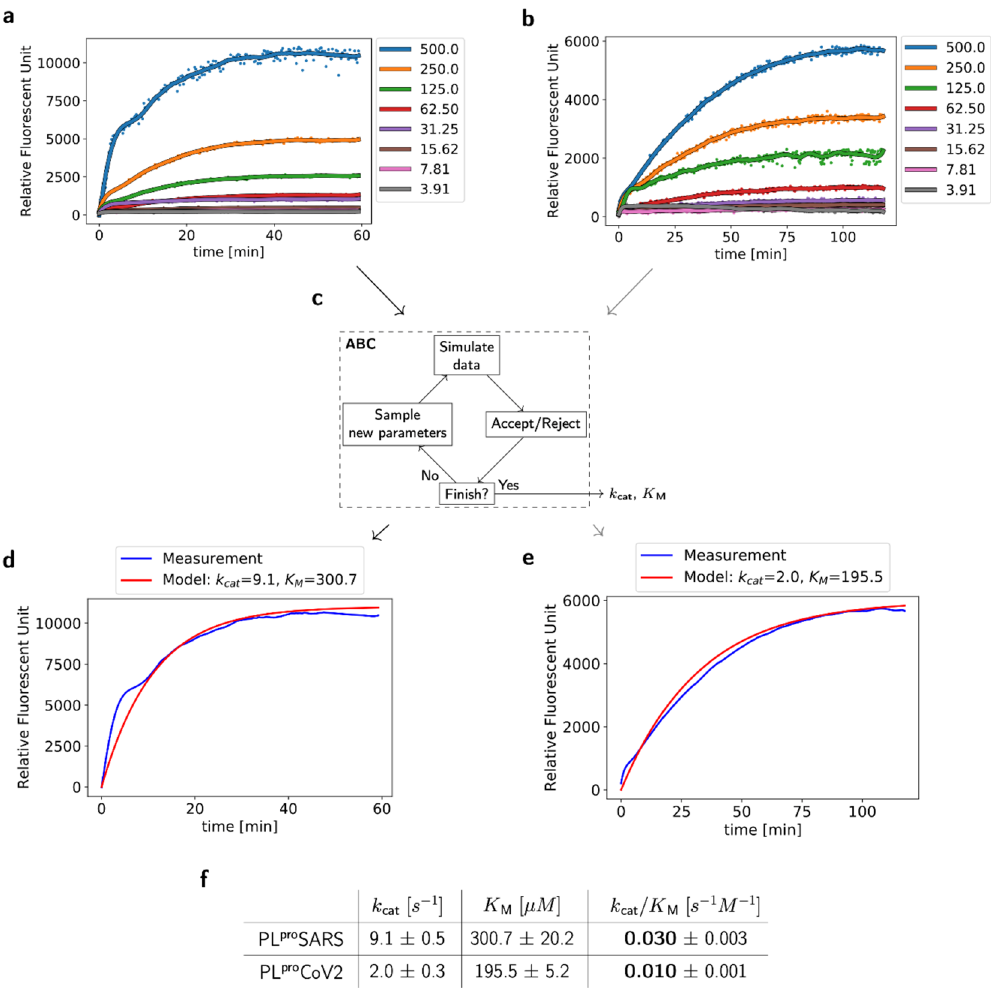
Figure 3. PL pro SARS displays a higher catalytic efficiency than PL pro CoV2 toward Ub-AMC. ( a , b ) Progress curves for the hydrolysis of Ub-AMC by PL pro SARS ( a ) and PL pro CoV2 ( b ). The concentrations of Ub-AMC are shown in the legend in nM, PL pro SARS and PL pro CoV2 were10 nM. ( c ) Four steps of the Approximate Bayesian Computation (ABC) for calculating values of kinetic constants k cat and K M . ( d , e ) A comparison of measurements (in blue) and solutions of the Michaelis–Menten model for given parameters of enzymatic constants found by the ABC method (in red) for PL pro SARS ( d ) and PL pro CoV2 ( e ) at 500 nM substrate concentration ( k cat and K M are expressed in s −1 and μM, respectively). ( f ) The kinetic data ( k cat , K M , k cat / K M ) for the Ub-AMC substrate of PL pro SARS and PL pro